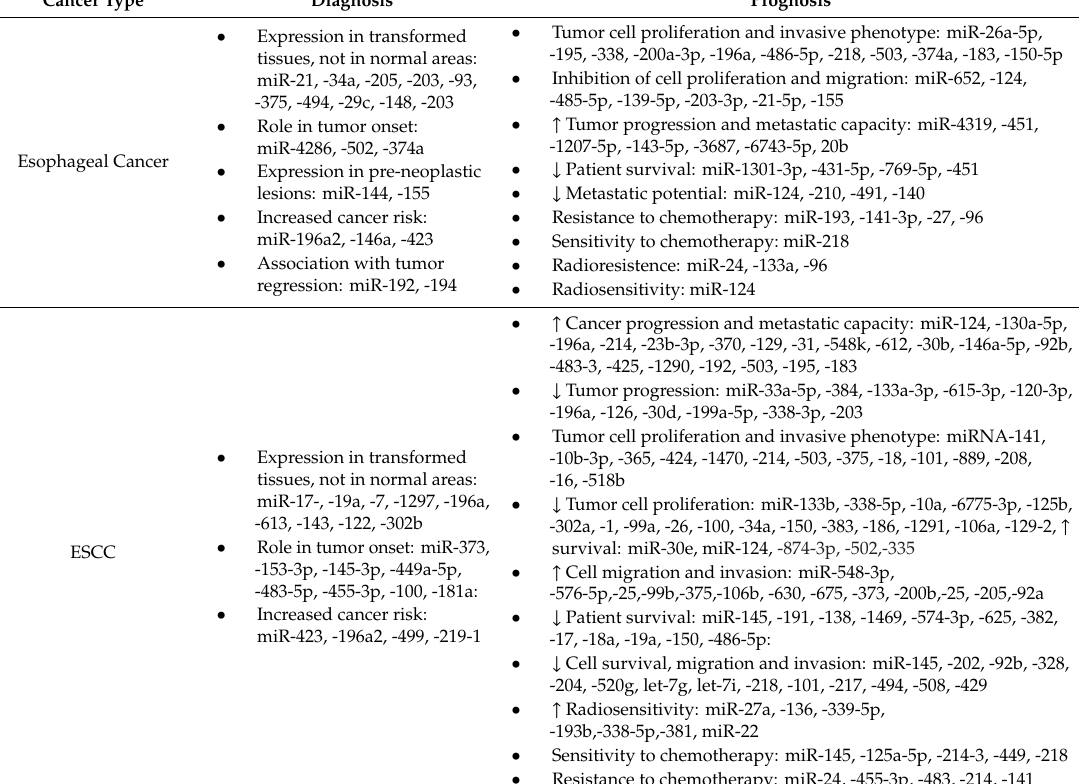
Table 3. MiRNA expression in esophageal and gastric cancers. In each case, expression has been associated with its functional (diagnostic and / or prognostic) value based on literature reports (PubMed search according to the following keywords: esophageal / gastric cancer &